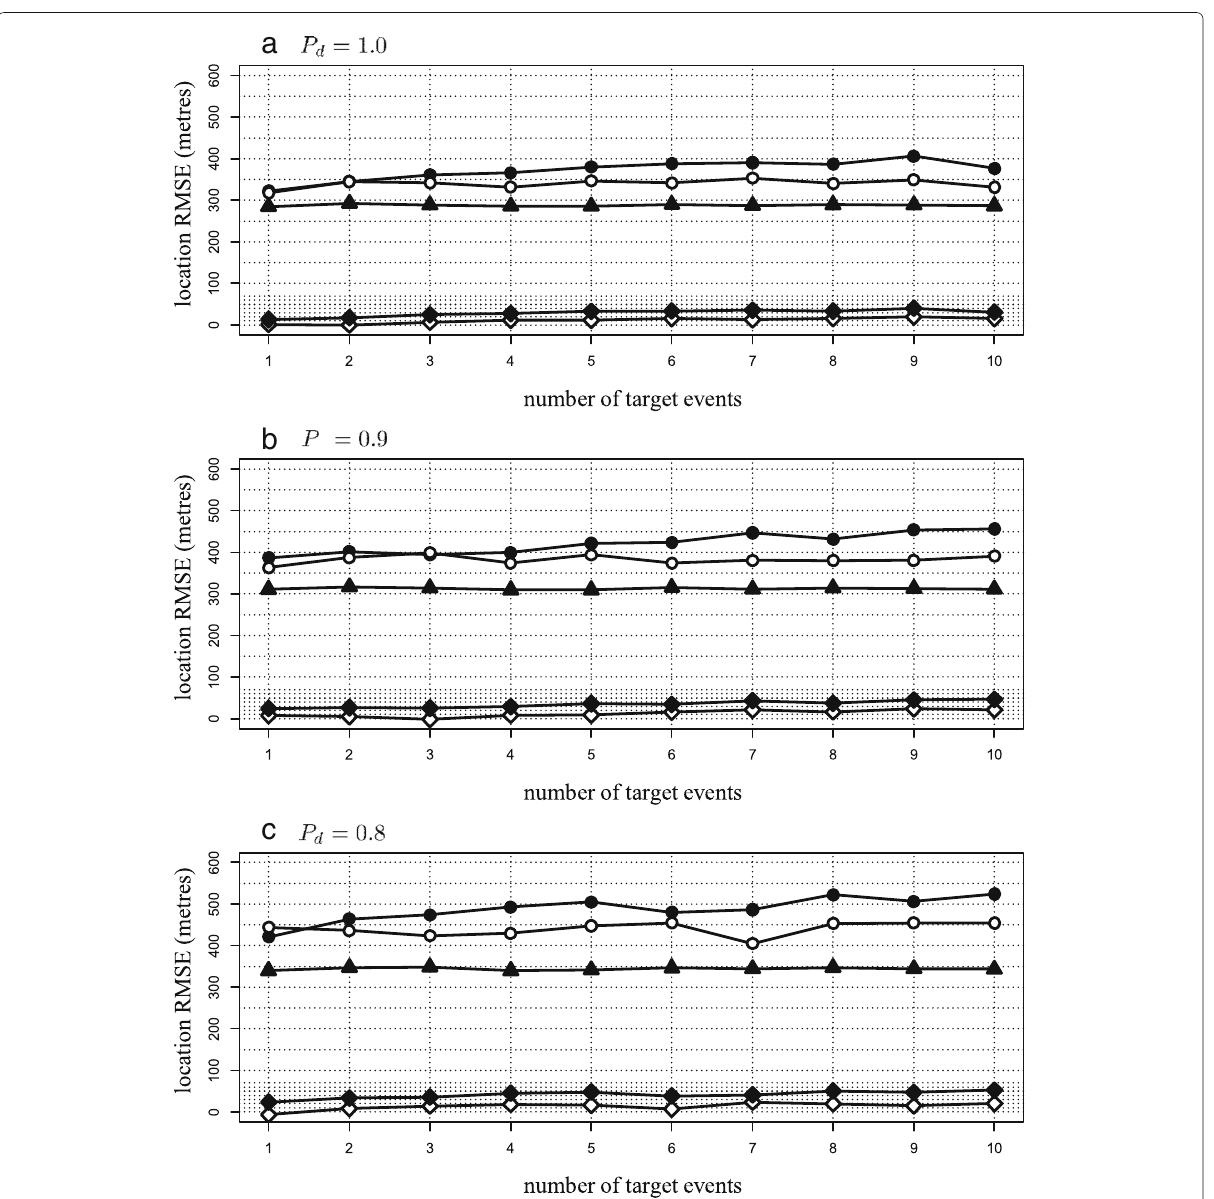
Fig. 6 Target localisation performance for scenario 3. The TALA RMSE ( blackcircles ), gTALA RMSE ( whitecircles ), and the CRLB RMSE ( blacktriangles ). The percentage differences between the performance of the TALA and ( i ) the CRLB ( blackdiamonds ) and ( ii ) the gTALA ( whitediamonds ). Results are averaged over all 1000 simulations. a P d = 1.0. b P d = 0.9. c P d =